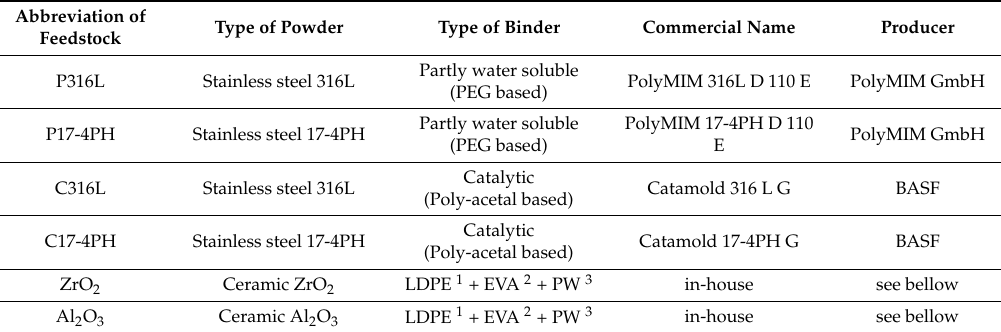
Table 1. Investigated powder injection molding (PIM) feedstocks.